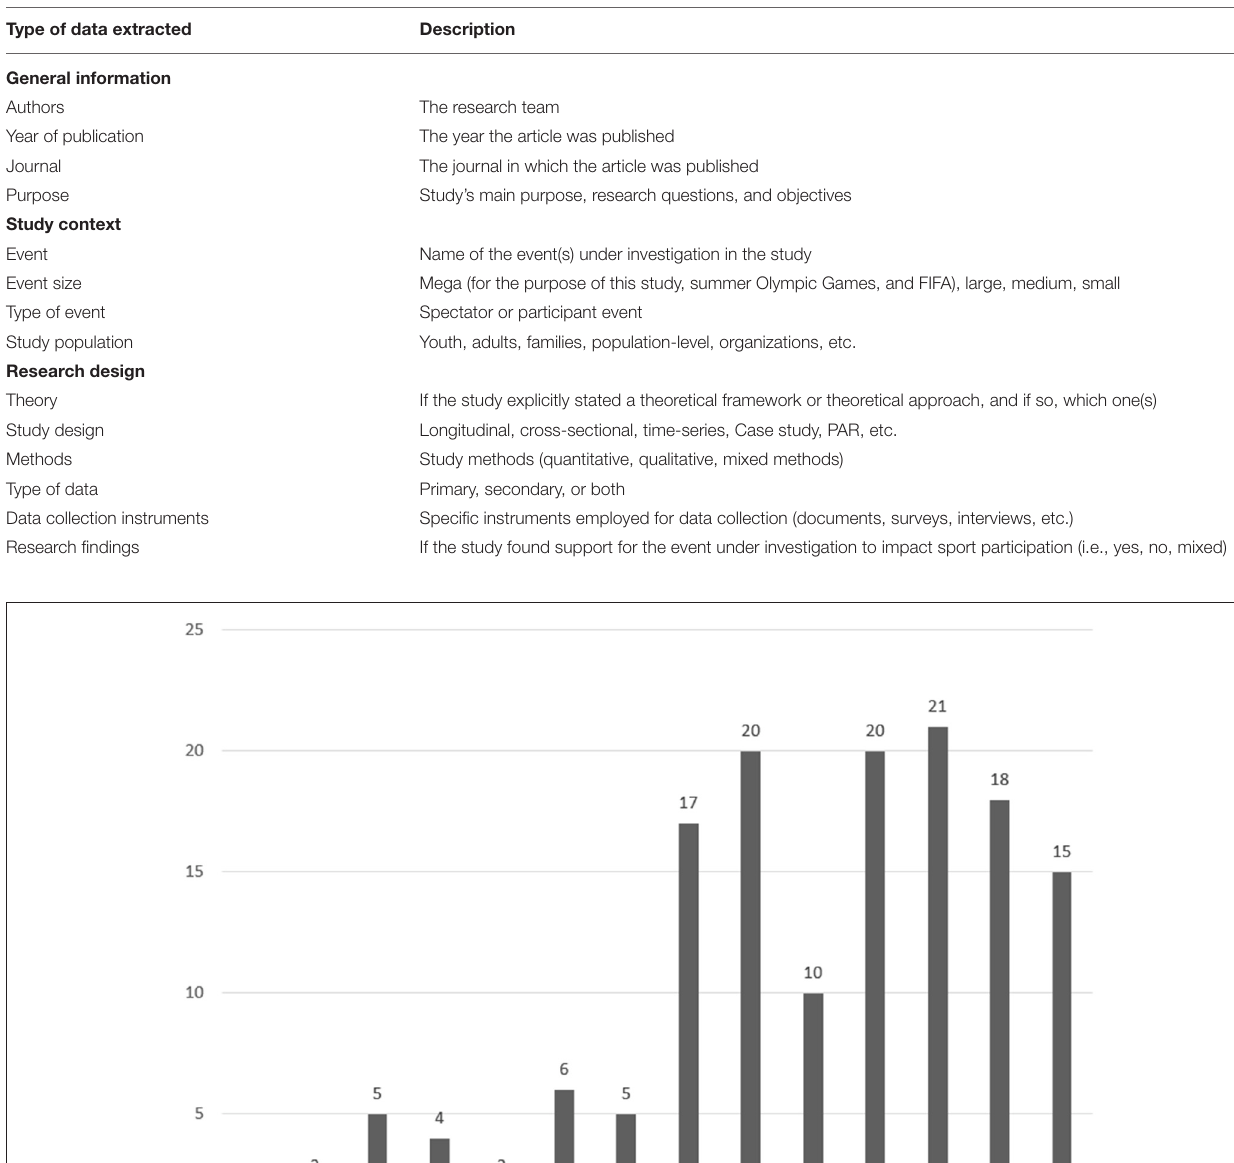
TABLE 2 | Data extraction categories.